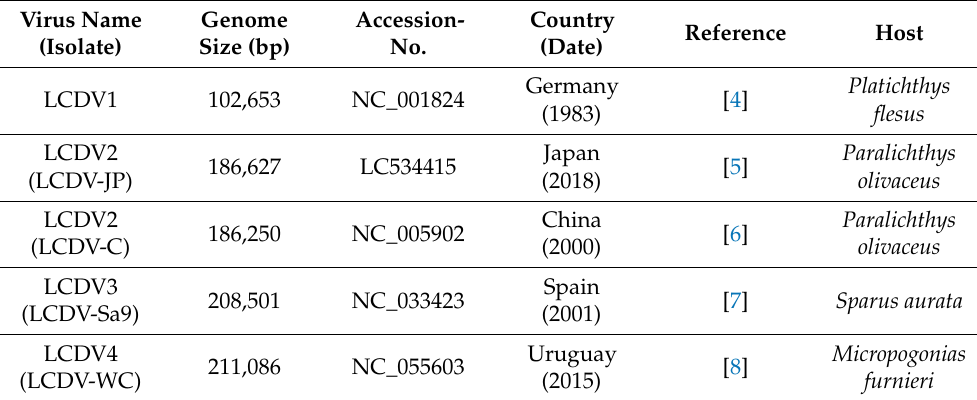
Table 1. Current LCDV complete genomes publicly